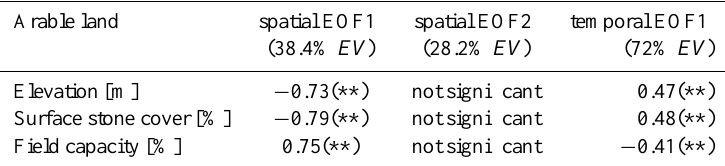
Table 2. Pearson correlation coefficients between EOFs and topographic and soil parameters for the arable test site; EV is the variance explained by the EOF.